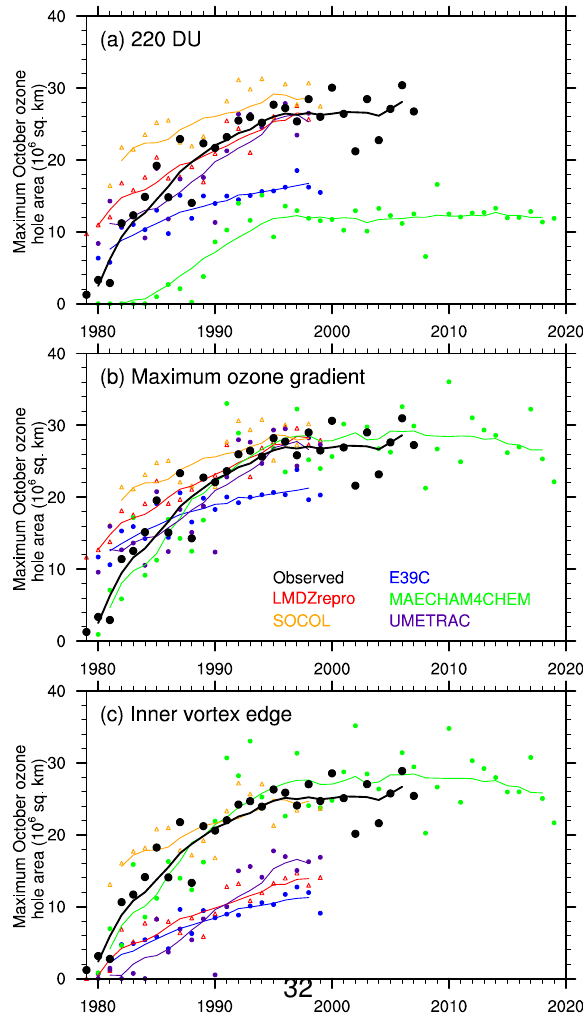
Fig. 6. Evolution of the size of the ozone hole from observations (black) and five CCMs (E39C: blue, LMDZrepro: red, MAECHAM4CHEM: green, SOCOL: orange, UMETRAC: purple). Maximum October ozone hole area using (a) 220 DU contour, (b) the maximum ozone gradient threshold, (c) the inner vortex edge threshold (see text for threshold definitions and Table 3 for threshold values). Solid lines are calculated using an 11 year running mean of the annual values.